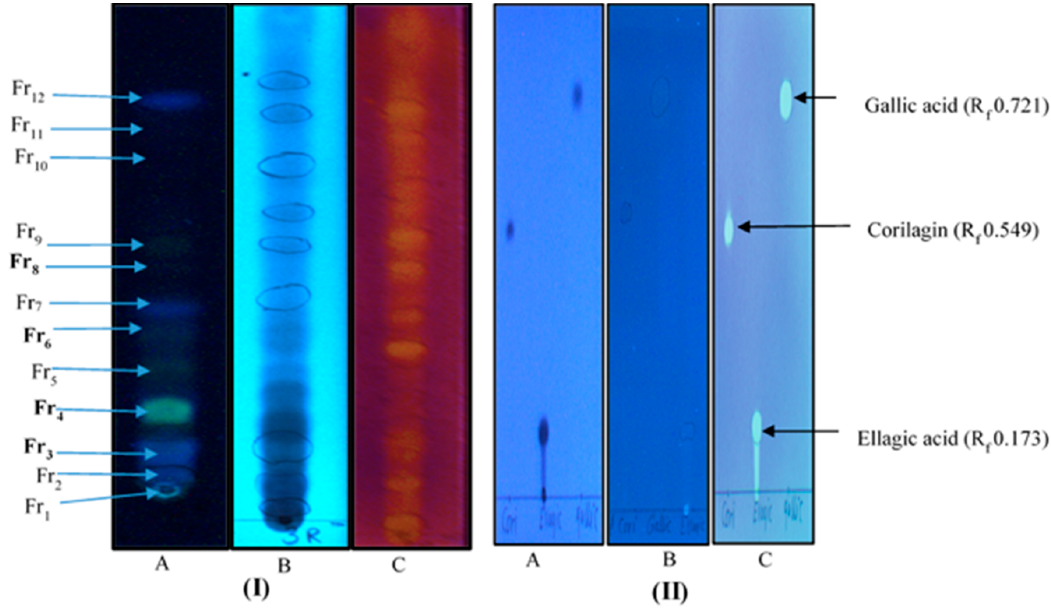
Figure 4. ( I ) RP 18 -TLC fractions ( Fr1 – Fr12 ) of a Soxhlet extract obtained with methanol from the root of A. leiocarpa . ( A ) Fractions at 366 nm, ( B ) fractions at 254 nm, and ( C ) fractions sprayed with the 2,2-diphenoyl-1picrylhydrazy (DPPH) reagent, with the yellow color indicating antioxidant activity. ( II ) Thin layer chromatography fingerprints of the standard compounds corilagin (R f 0.549), ellagic acid (R f 0.173), and gallic acid (R f 0.721) ( A ) at 254 nm, ( B ) at 366 nm, and ( C ) after being sprayed with the DPPH reagent. Fractions marked with bold font ( Fr 3 , Fr 4 , Fr 6 , and Fr 8 ) were obtained in sufficient amount for antimycobacterial testing.